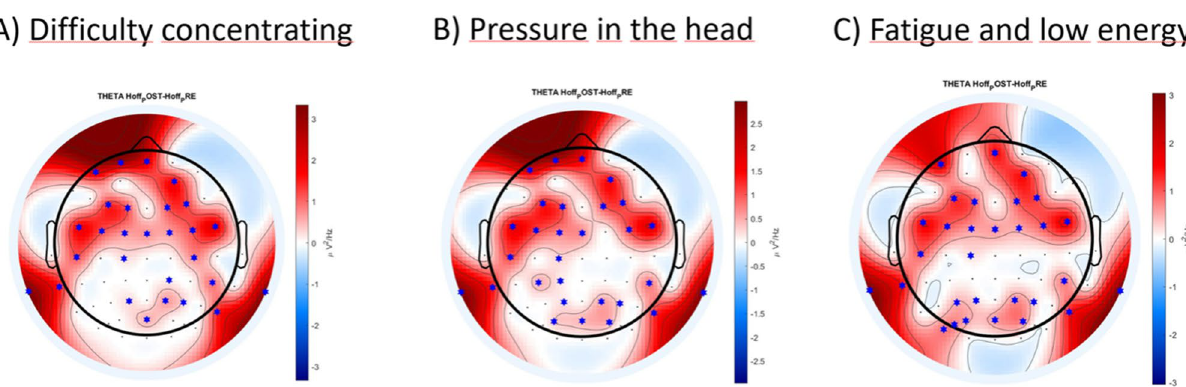
Figure 4. A topological plot for delta and theta frequency band of the concussion group. It displays the difference of power spectral density, between POST and PRE, only for the statistically significant electrodes (0.032 ≤ p ≤ 0.047, represented by a blue star in the figure). The delta band presented a few significant electrodes (6 out of 64) on the frontal and occipital cortex, whereas the theta band showed more distributed significant electrodes (36 out of 64) over the scalp.